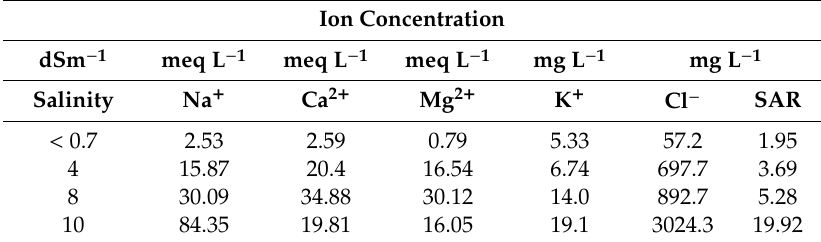
Table 2. Chemical properties of irrigation waters used for the experiment; tap water as control from the greenhouse (control, EC = 0.7 dSm − 1 ); brackish groundwater (EC = 4 dSm − 1 ) from BGNDRF,